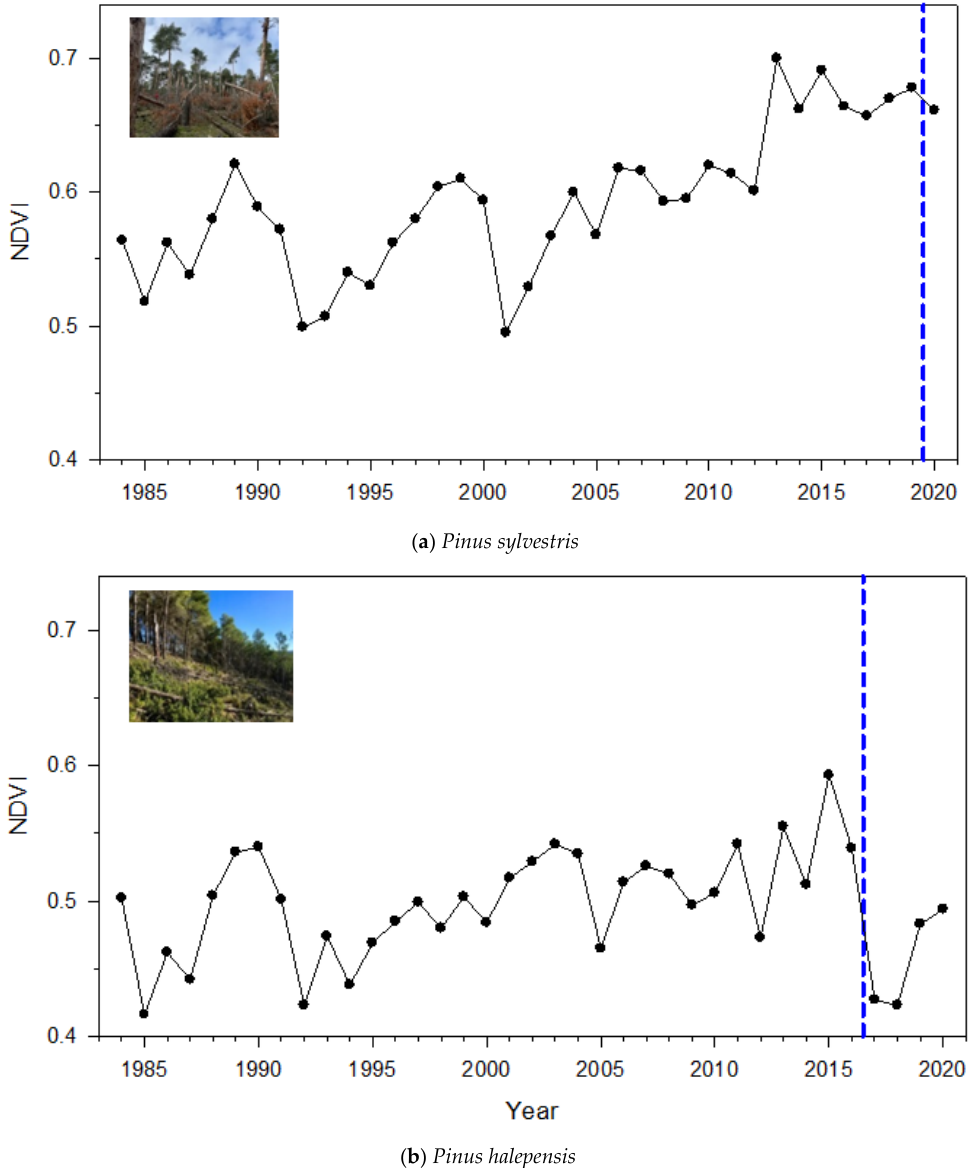
Figure 1. Annual NDVI data of the affected ( a ) Pinus sylvestris and ( b ) Pinus halepensis stands. The dashed vertical lines indicate the change in NDVI after the storm impacts. The photographs show views of the stands affected by windstorms. The P. sylvestris site (41°05′07″ N, 01°30′37″ W, 1247 m above mean sea level; situated near the Orcajo village) is located in a gentle (10°) slope with NE exposure and rocky soils. It was affected by the Gloria storm, which impacted eastern Spain and southernmost France with high winds and heavy rainfall on late January 2020 (Figure S1a). Mean tem- perature is 9 °C (mean minimum and maximum temperatures are −3.0 °C and 18.0 °C, respectively) and total annual precipitation is 492 mm, with a period of water shortage from July to September (data from Daroca station, 1.41° W, 41.11° N, 749 m above mean sea level). Snow precipitation may fall from November to February. The soils are acid, shallow (30–50 cm deep) developed over sandstones. The natural vegetation is dominated by Mediterranean oaks ( Quercus ilex, Quercus faginea ) and dwarf shrubs ( Genista scorpius, Lavandula stoechas, Arctostaphylos uva-ursi, Thymus vulgaris, Cistus spp.). We sampled an affected area of ca. 18,000 m 2 . The mean height of dominant trees is 12 m and the mean tree-to-tree distance is 4 m. Tree density ranges from 80 ind ha −1 in the gap of the affected patch to 1100 ind ha −1 in the little affected buffer zone, respectively. In this site, thinning was done in the 2000s and 2010s to reduce stand density, which proved the existence of abundant stumps in the sampled stands. The P. halepensis site (40°08′21″ N, 0°41′57″ W, 879 m above mean sea level; situated near the Olba village) is located in a steep (30°) slope with S-SE exposure and rocky, thin (30–40 cm depth) soils. It was affected by a severe windstorm related to a cold front af- fecting north-eastern Spain from 17 to 20 January 2017 (Figure S1b). Climate in this area is warmer than in the P. sylvestris site. Mean temperature is 13.4 °C (mean minimum and maximum temperatures are 1.3 °C and 30.4 °C, respectively) and total annual precipita- tion is 470 mm, with a period of water shortage lasting from June to September (data from Sarrión station, 0.82° W, 40.14° N, 988 m above mean sea level). Winter snow precipitation is rare and lasts few days. Here, we sampled an affected area encompassing 9500 m 2 , but the affected area included circa 5 ha. Tree density ranges from 70 ind ha −1 in the gap to 750 ind ha −1 in the undisturbed, dense stands. The mean height of dominant trees is 9 m and the mean tree-to-tree distance is 2 m. The natural vegetation is a typical Mediterranean